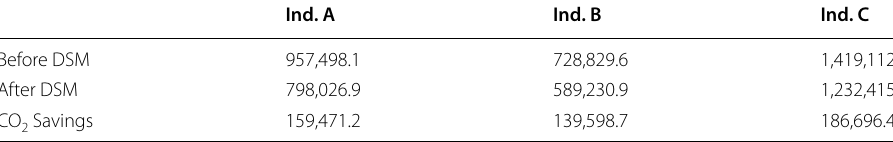
Table 11 Comparison of CO